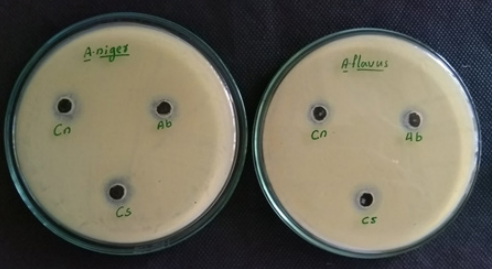
Fig. 10. Antifungal activity against A.niger and A.flavus from the figure,cn-Chitin, cs-Chitosan, Ab- Antibiotic